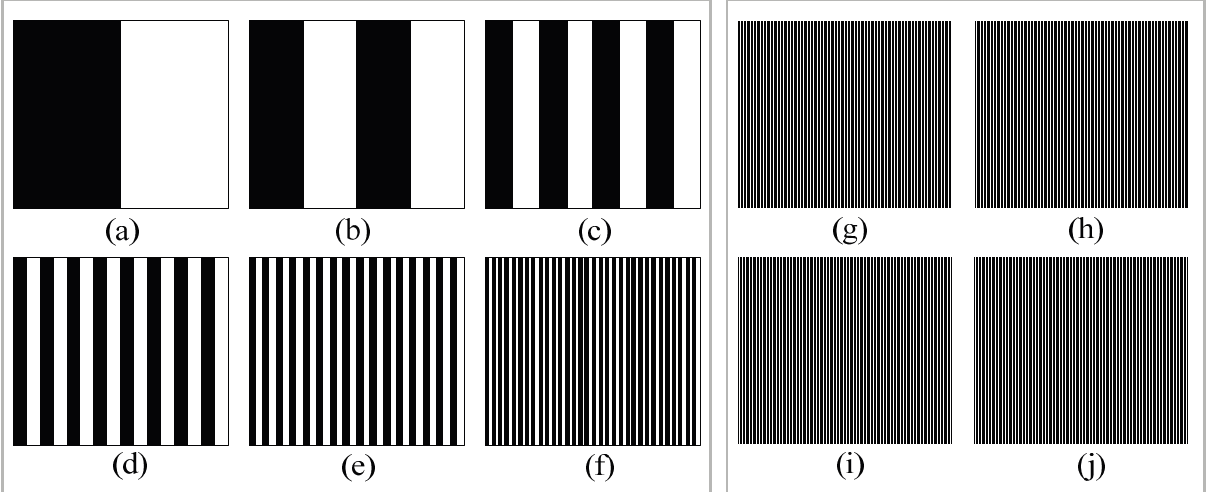
Figure 4. All projected images.